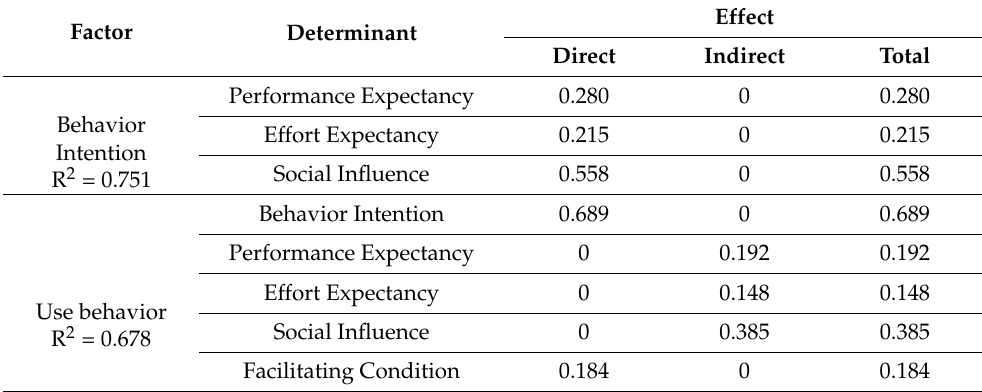
Table 7. Direct indirect and total effect implied in the path model.